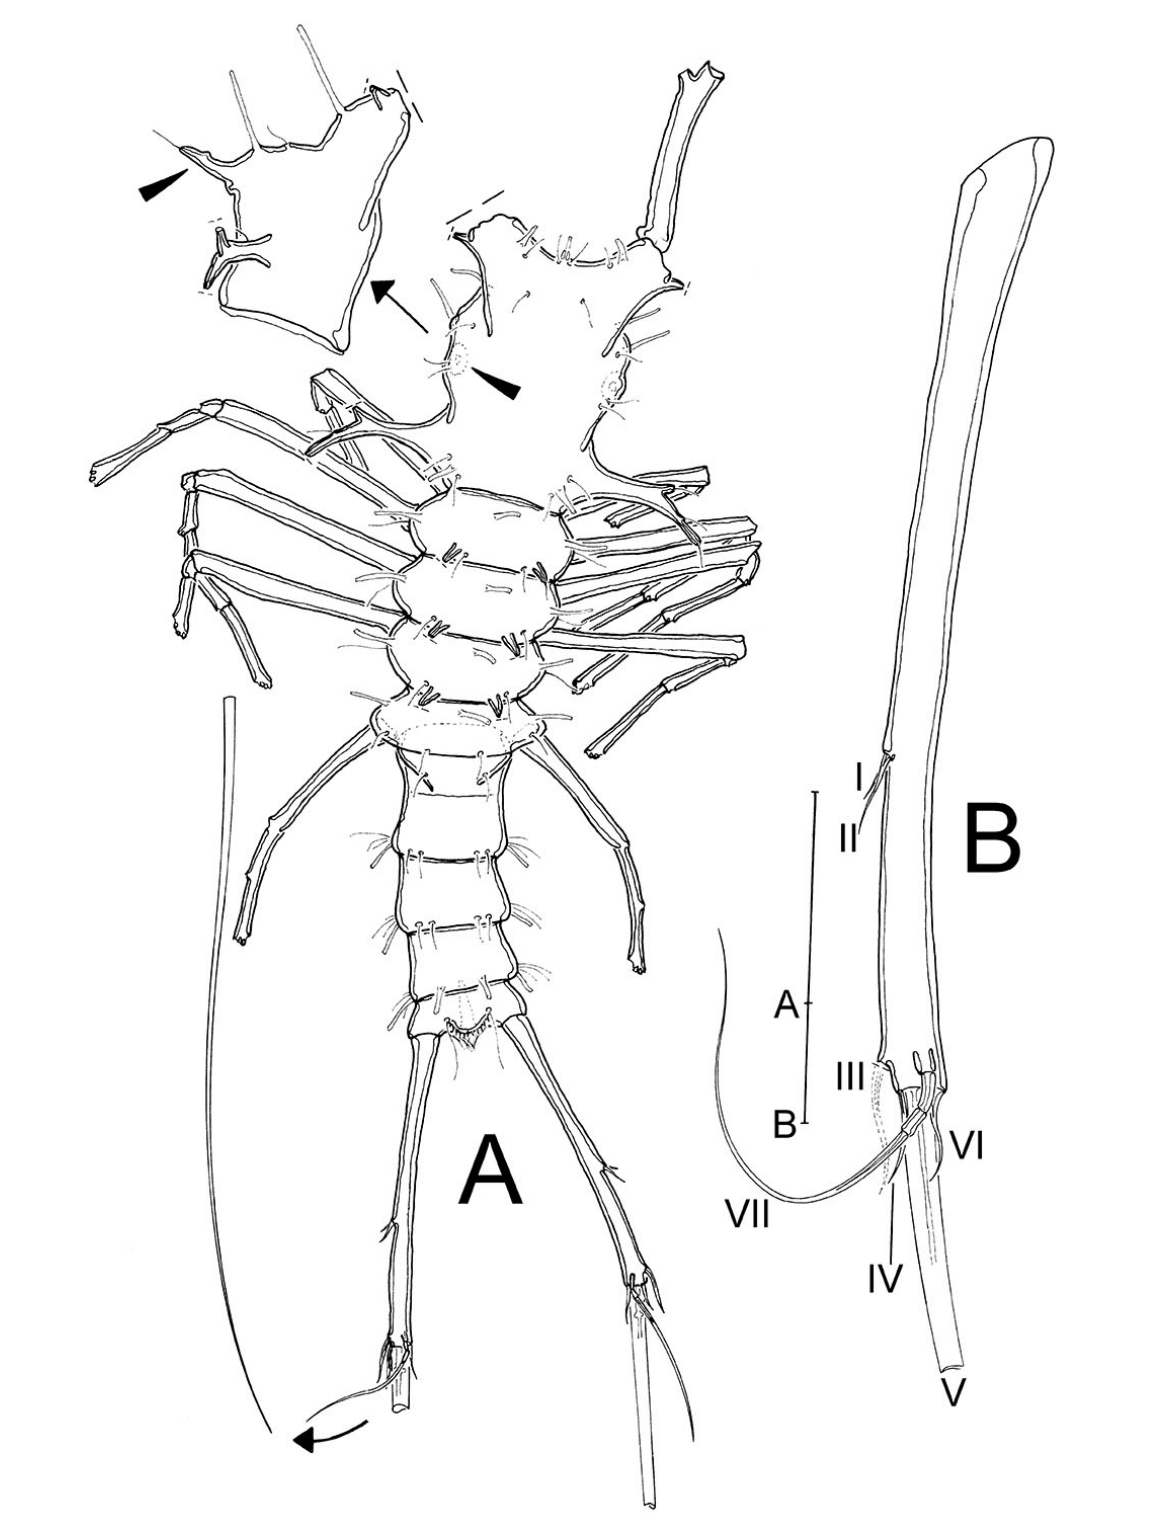
Fig. 3. Poropsyllus menzelae gen. et sp. nov., female holotype (HUJ INVCRUCOP808). A . Habitus, dorsal view; on the upper left: cphth in lateral view; arrowheads point to the CLVPa. B . Left FR, dorsal view. Scales bars: A = 100 µm; B = 50